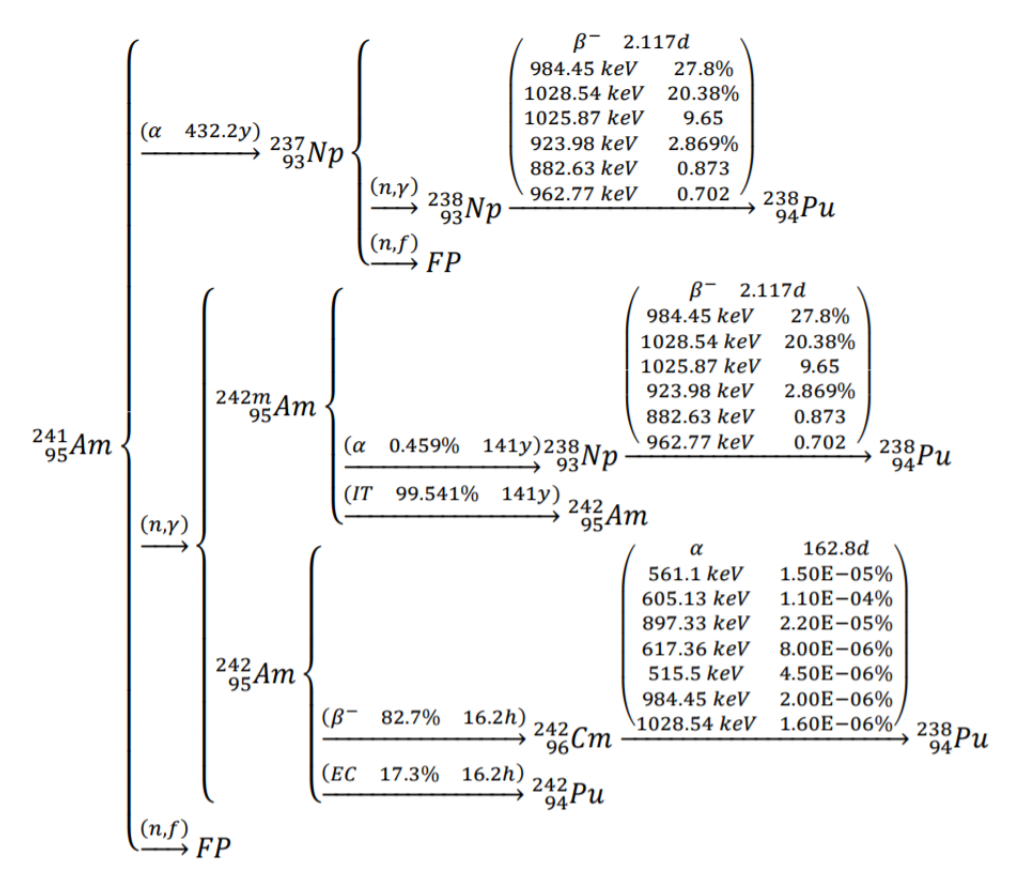
Figure 6. Am-241 related decay / reaction scheme